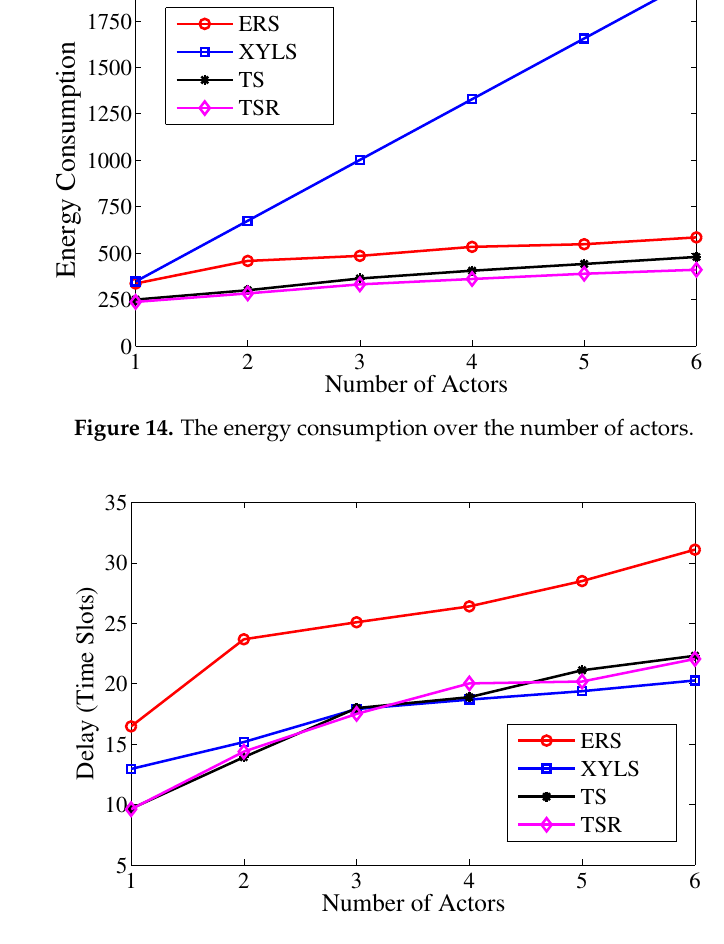
Figure 15. The search delay over the number of